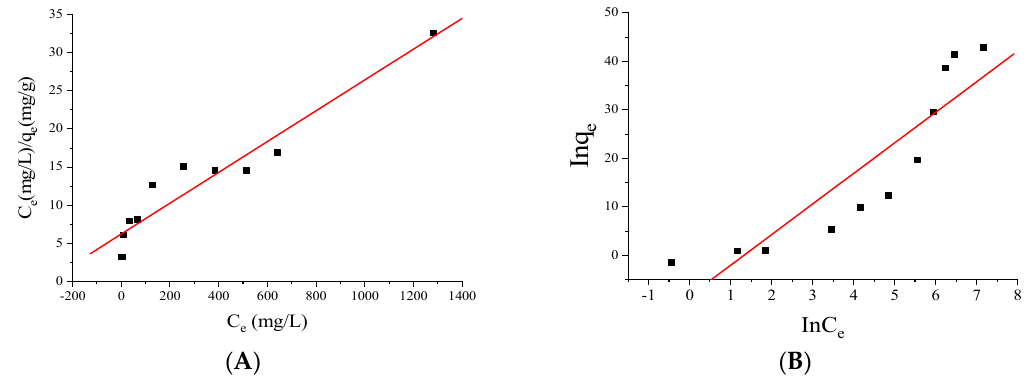
Figure 10. The linear fitting curves of the Langmuir ( A ) and Freundlich ( B ) models.